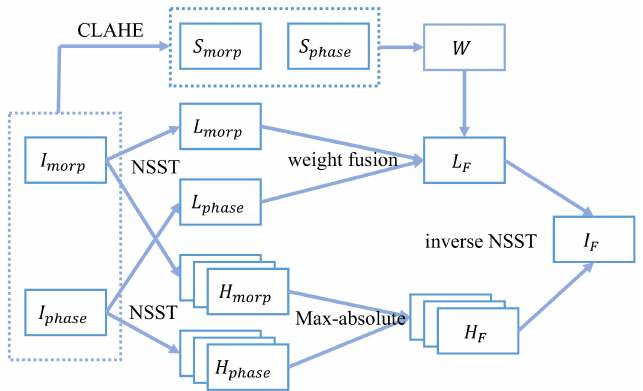
Figure 2. Framework of the proposed